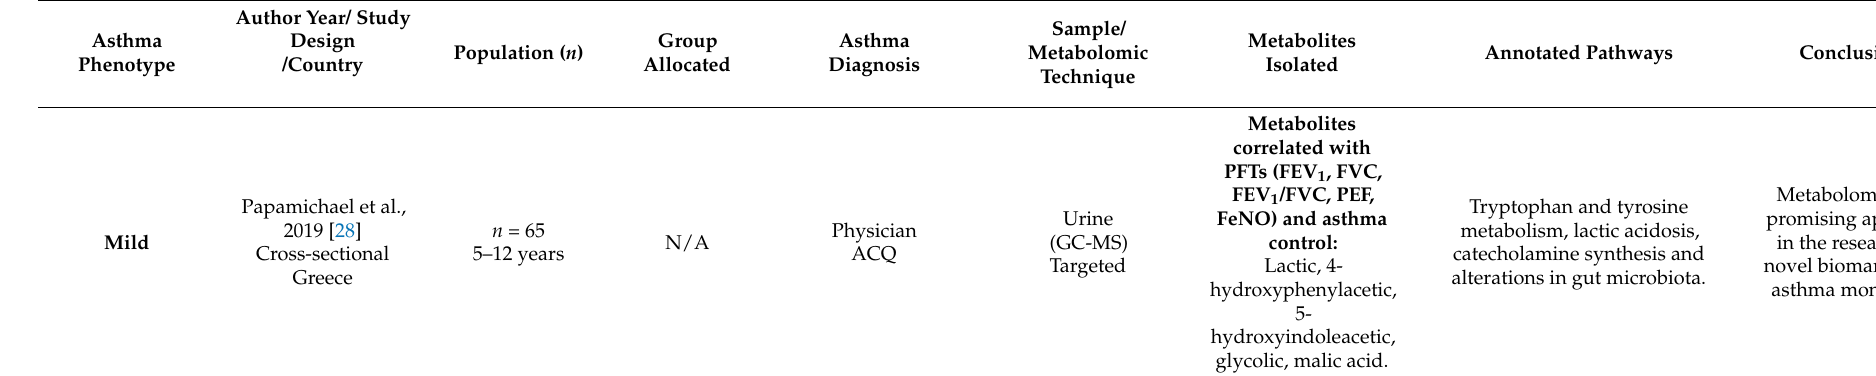
Table 2. Characteristics of metabolomic studies reviewed on pediatric asthma